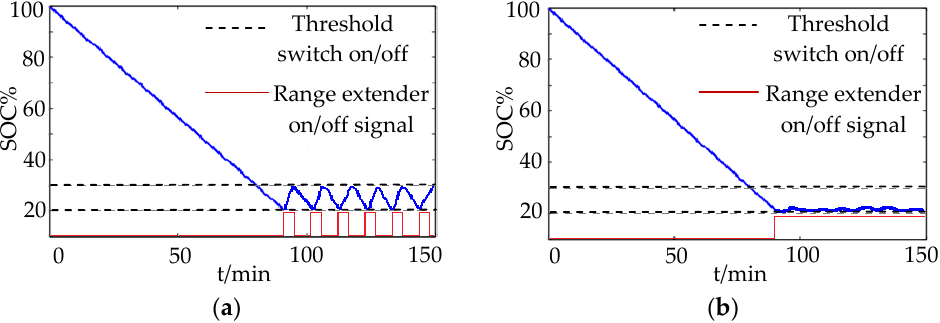
Figure 2. EREV control methods in CD-CS operation mode ( a ) Constant power control strategy; ( b ) Power following control strategy.